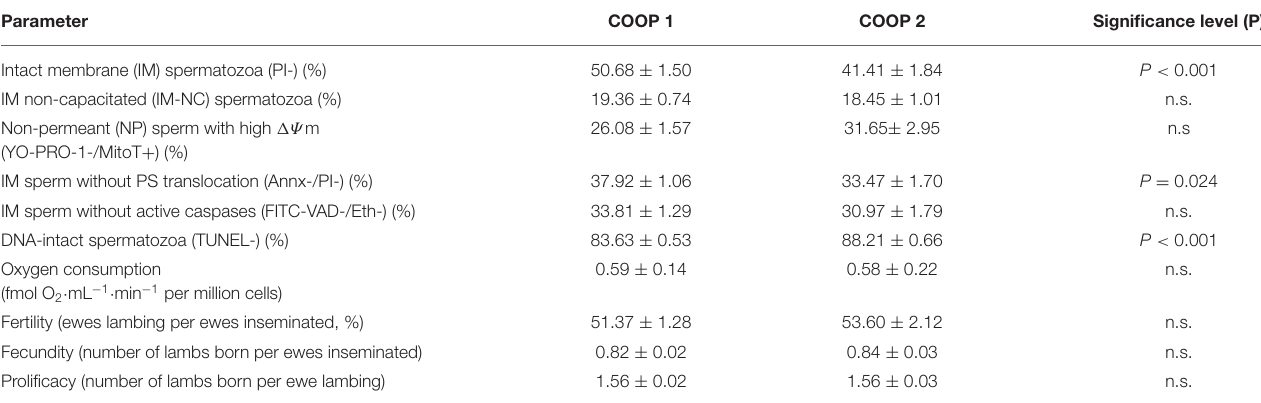
TABLE 3 | Differences in analyzed parameters between cooperatives. Parameter